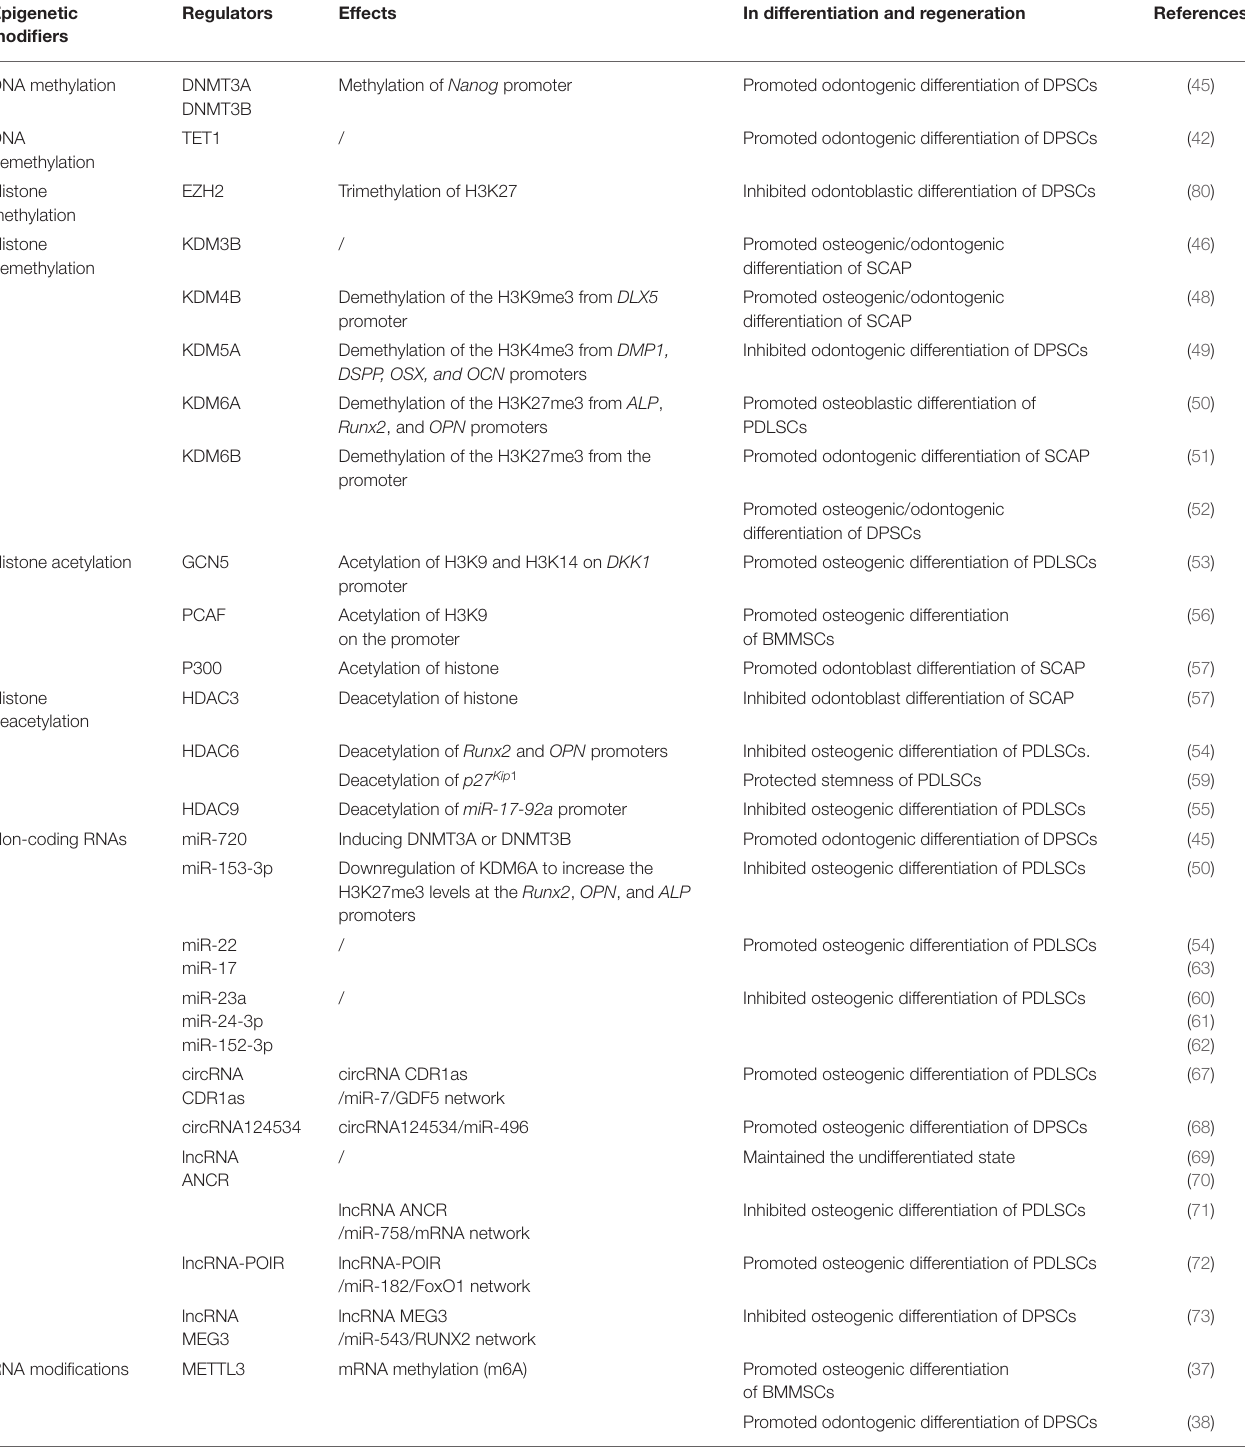
TABLE 1 | Epigenetic modifiers in the regulation of